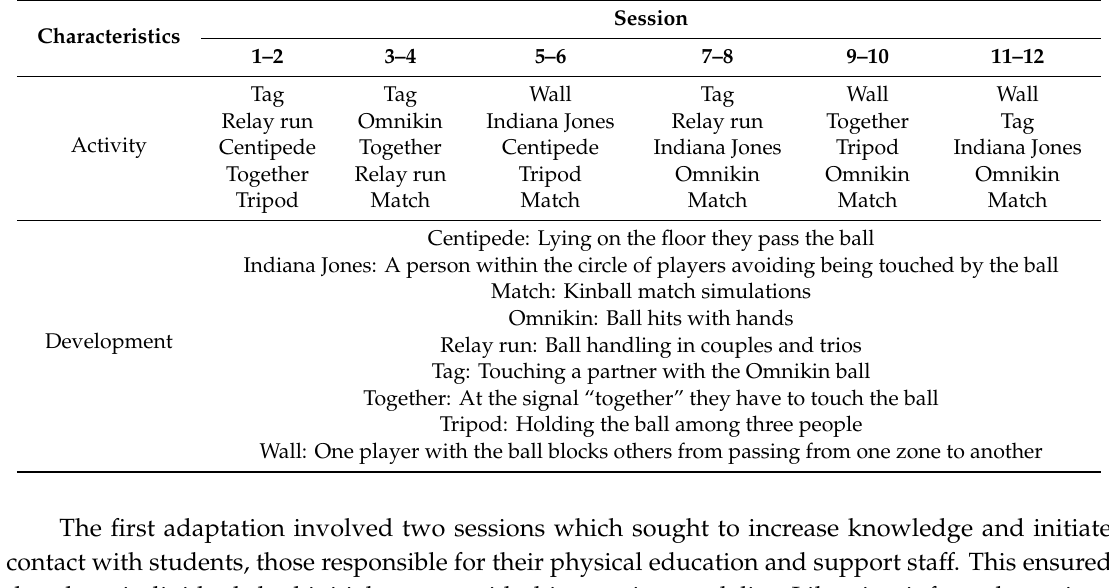
Table 1. List of activities of the Kin-ball intervention